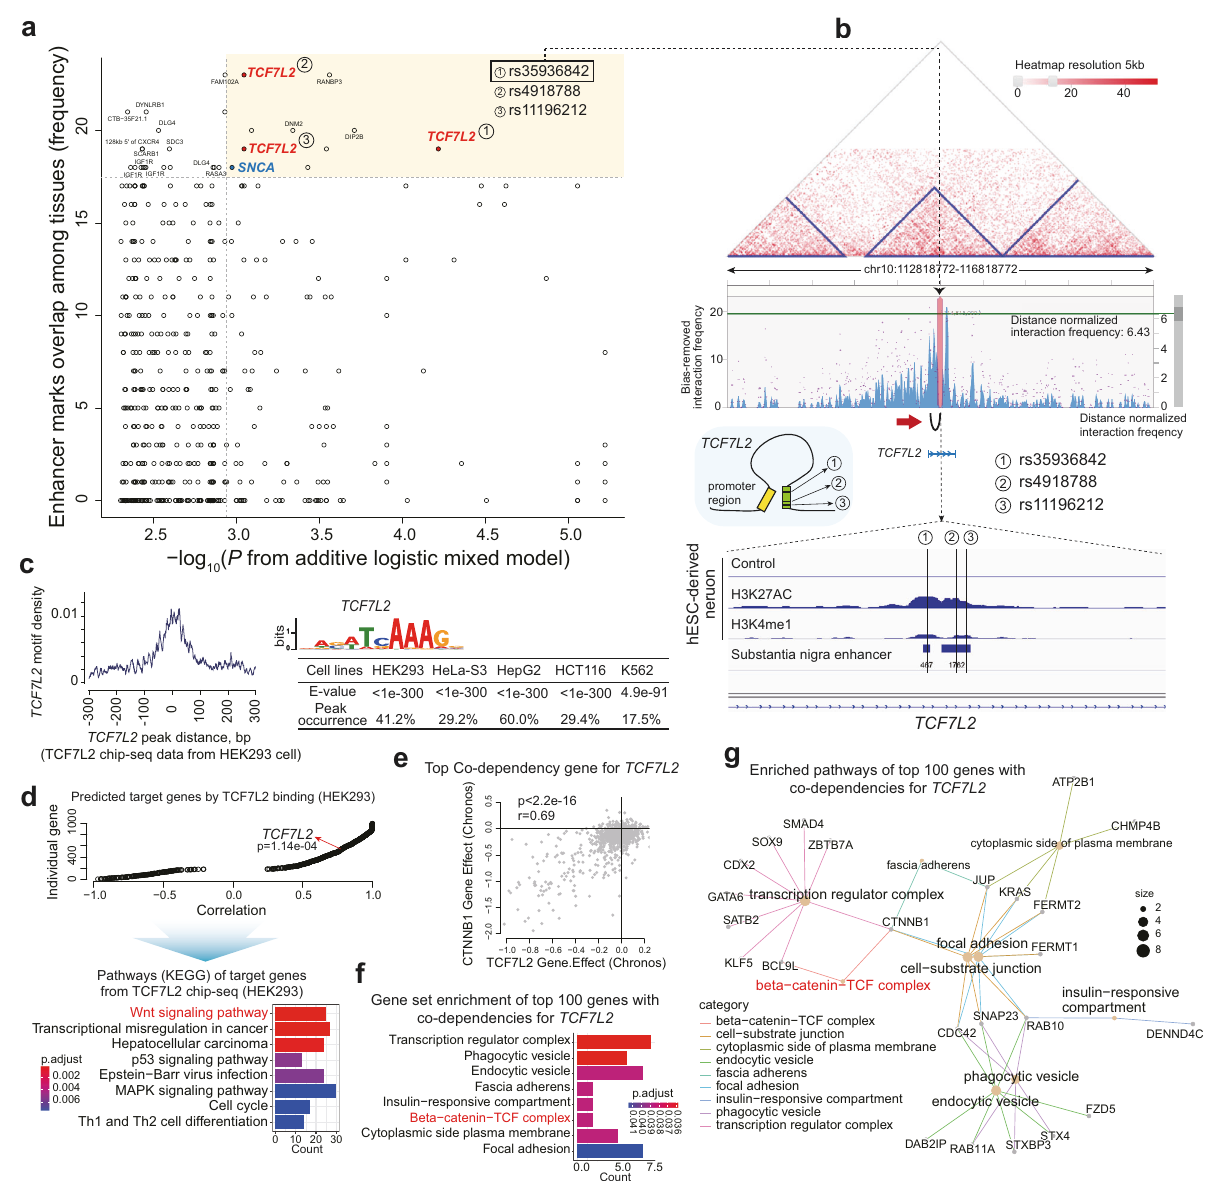
Fig. 3 Association of SNVs in enhancer regions with risk of PD. a Top PD risk-associated SNVs, including those in TCF7L2 and SNCA . b Identi fi cation and analysis of 3D genomic interactions of risk loci in TCF7L2 gene enhancer regions. c Motif analysis results for TCF7L2 ChIP- seq data in multiple cell lines from ENCODE. d Pathway analysis using predicted TCF7L2 binding target genes from TCF7L2 ChIP-seq data in HEK292 cell lines. e CTNNB1 is the top codependent gene for TCF7L2 from DepMap data analysis (Pearson correlation analysis). f, g Pathway analysis using the top 100 codependent genes for TCF7L2 . PD Parkinson ’ s disease; SNVs single-nucleotide